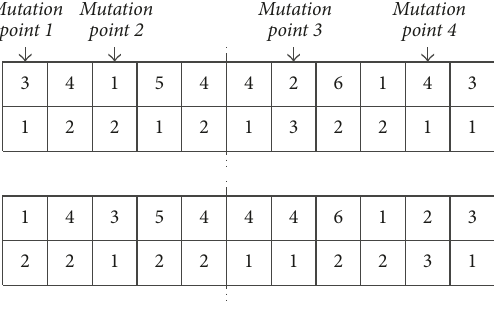
Figure 8: The process of mutation.